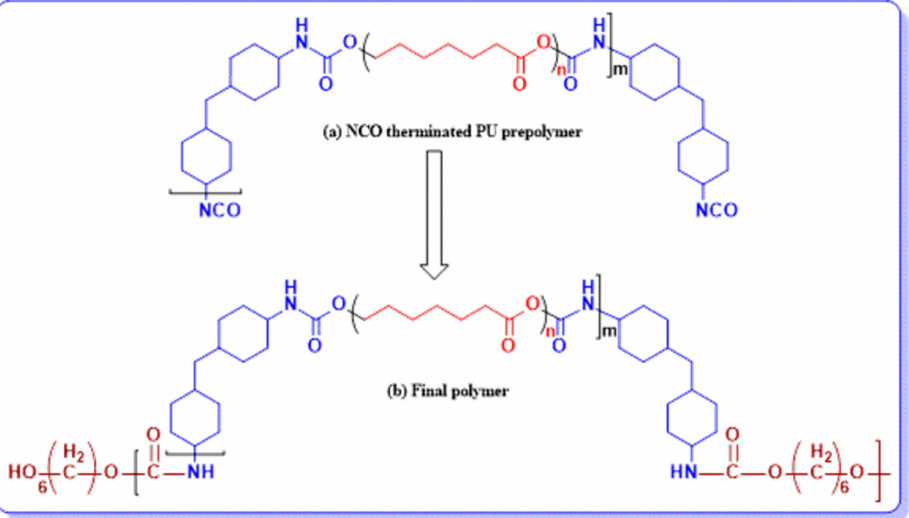
Figure 1. Polyurethane elastomer synthesis using polycaprolactone diol as SS: ( a ) pre-polymer and ( b ) final